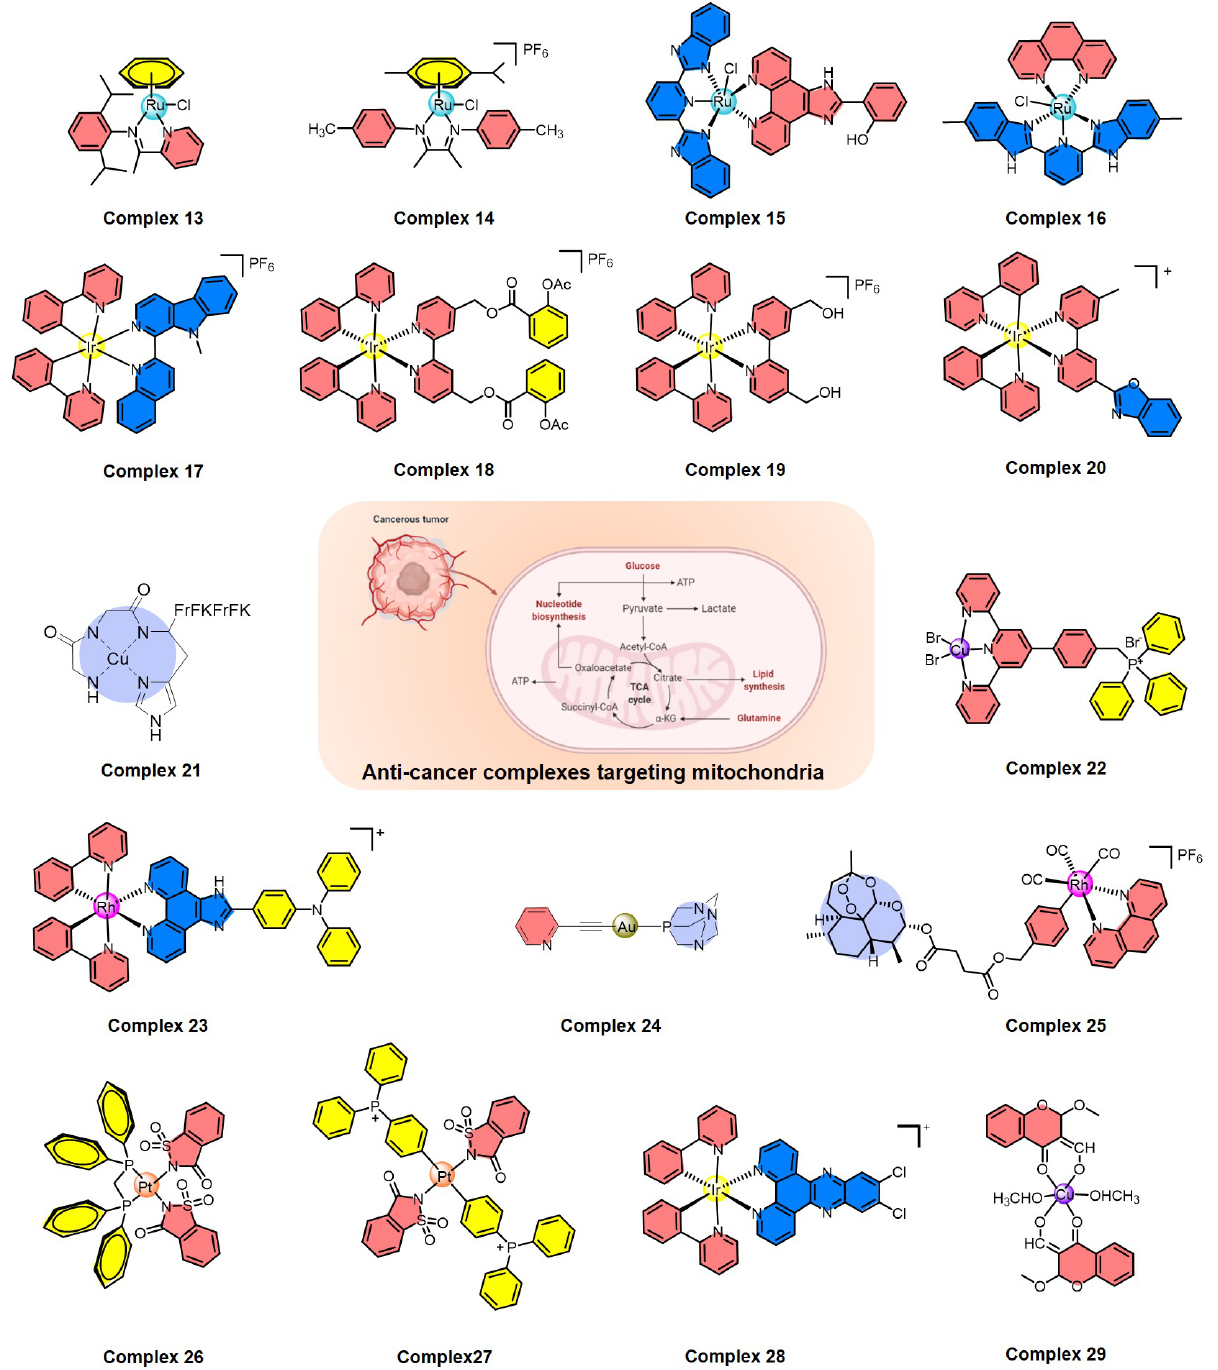
Figure 4. Summary of metal complexes activating ROS-mediated signaling by mitochondrial dysfunction.